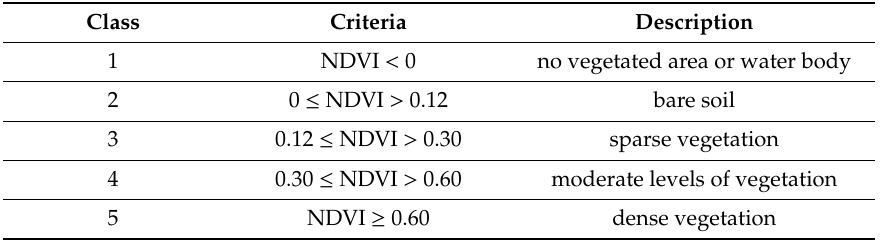
Table 1. Description of the criteria to classify NDVI pixels by using decision tree classification (DTC) classifier.